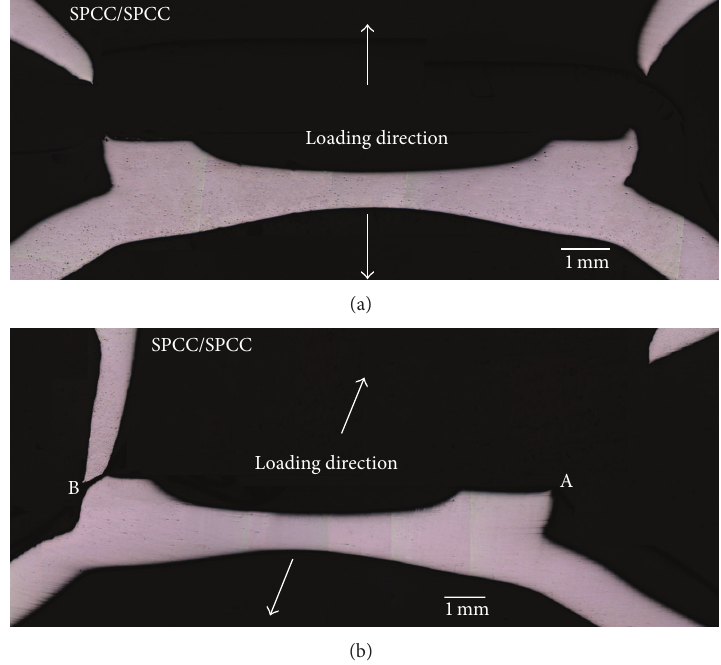
Figure 10: Cross-sectional macrographs of completely failed SPCC/SPCC FSSW joints under (a) a pure opening load (𝜙 = 0 ∘ ) and (b) a combined load of 𝜙 = 22 ∘ ,